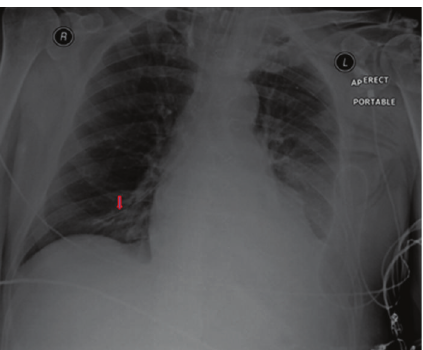
Figure 36: The quality of a portable AP radiograph is not always optimal because of the technical factors prevailing. The tip of the NGT in the lower lobe bronchus is obscured by lung markings (arrow).